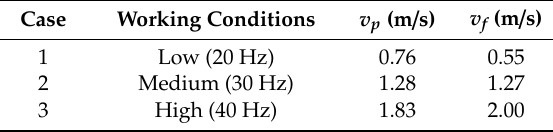
Table 4. Input parameters in Fluent at di ff erent cases.